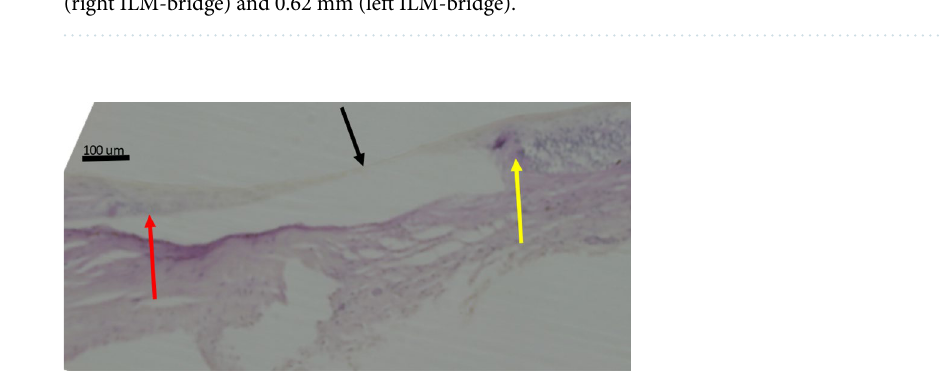
Figure 2. Histo-photograph showing an inner limiting membrane (ILM) defect (please see Fig. 1) in greater magnification (black arrow), yellow and red arrow: ends of the retinal layers (except for the ILM) ending abruptly (yellow arrow) or smoothly (red arrow); in the ILM-defect region, the retina consists only of the inner limiting membrane, with the retinal pigment epithelium, Bruch’s membrane and choroidal structures additionally